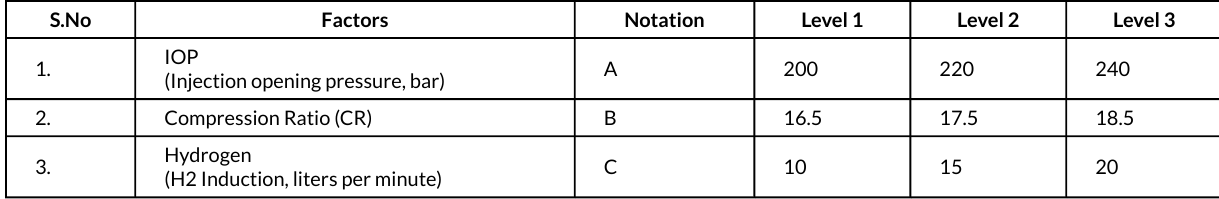
TABLE 1. PROCESS PARAMETERS FOR EXPERIMENTATION AT DIFFERENT LEVELS